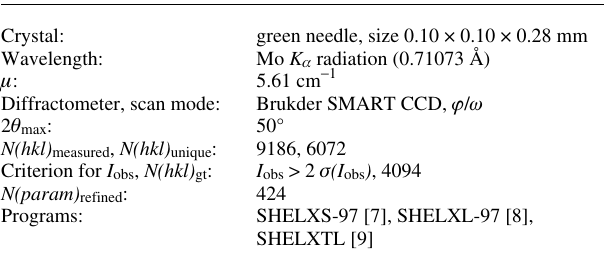
Table 1. Data collection and handling.